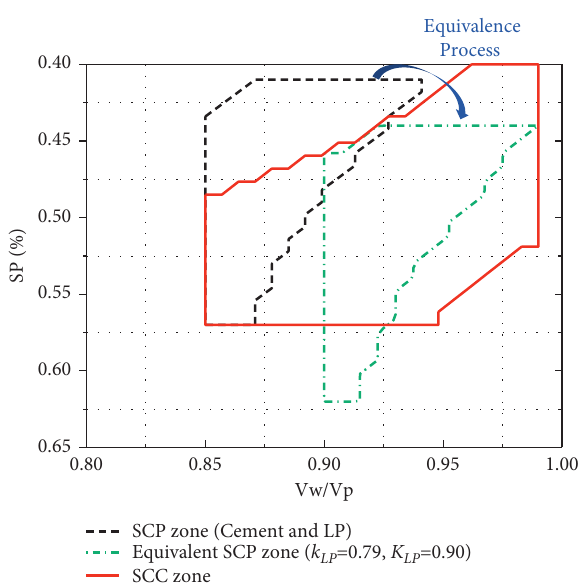
Figure 11: Comparison of different zones with cement and LP as